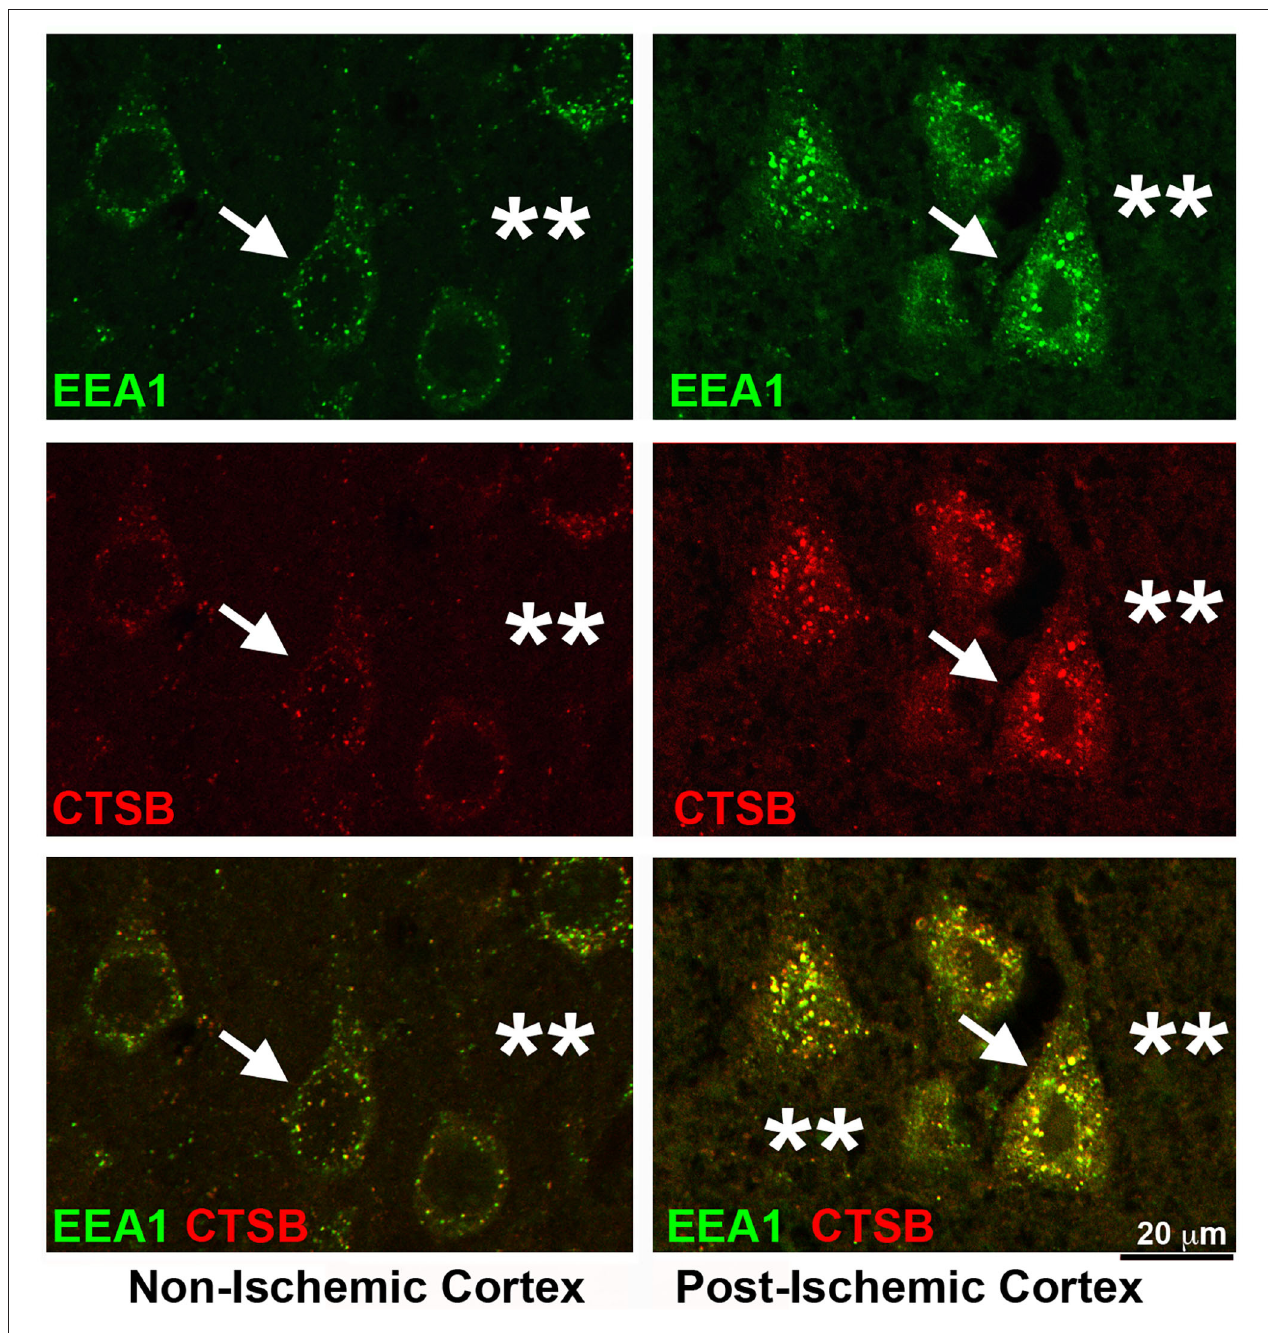
FIGURE 6 | Confocal imaging of neuronal buildup of EEA1 and CTSB after stroke. Brain section obtained from a rat subjected to 2h of MCAO followed by 24h of reperfusion, double-labeled with EEA1 (green) and CTSB (red) antibodies and examined by confocal microscopy. Left panels display the contralateral non-ischemic cortex; Right panels show the ipsilateral post-ischemic cortex. Upper row : EEA1 immunolabeling; Middle row : CTSB immunolabeling; Lower row : EEA1 (green) and CTSB (red) double-immunolabeling. Arrows point to neuronal soma; and stars denote the immunostaining outside neuronal soma.